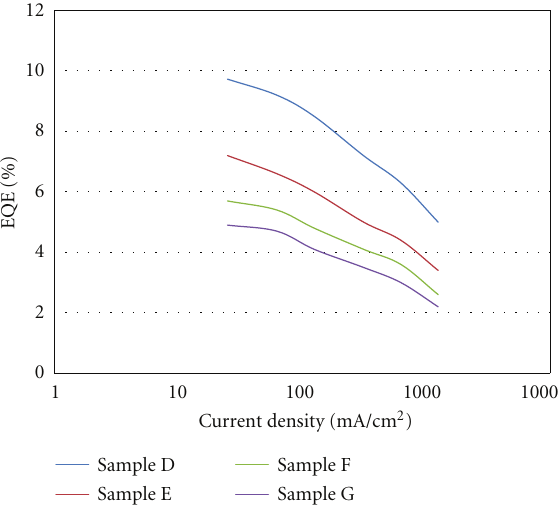
Figure 9: J-EQE characteristics in all RB-type samples.